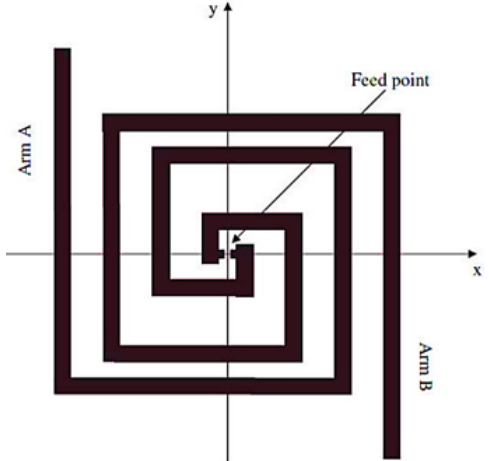
Figure 3. Geometry of a square-spiral nanoantenna (sourced from the work in